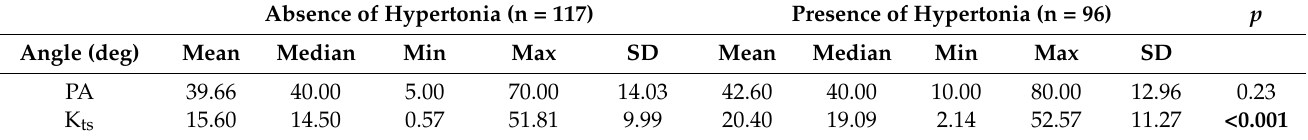
Table 1. The popliteal angle values (PA) and knee angular position at the end of swing/initial stance (K ts ) were larger in the limbs with clinically detected knee flexors hypertonia, but the differences were not statistically significant for PA when hypertonia had been identified using TAS at slow velocities (HYP vs ).